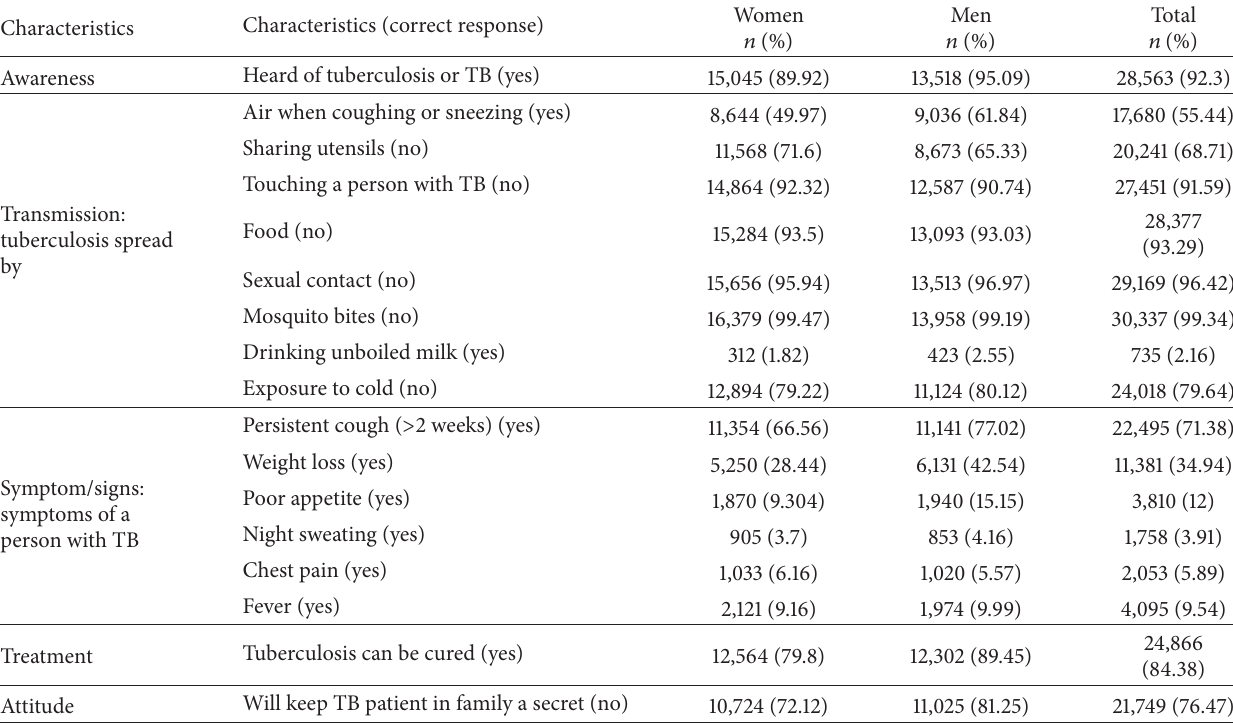
Table 2: TB awareness and respondents correct knowledge on TB transmission, symptoms, and treatment, Ethiopia 2011.